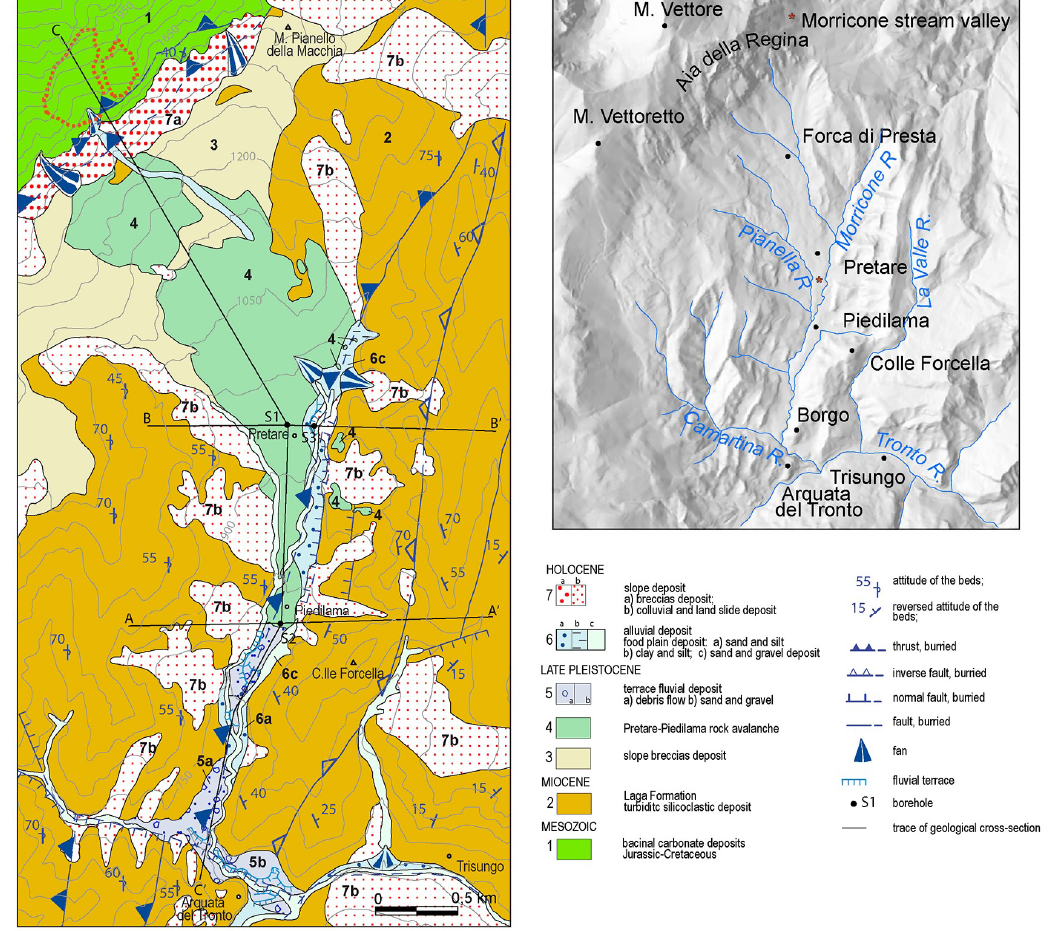
Figure 5. Geological sketch map of the investigated area realized by a 1:10.000 scale field survey (for location see the box in Figure 2); the contour line interval is 75 m. Hillshade of the study area including the main drainage network.